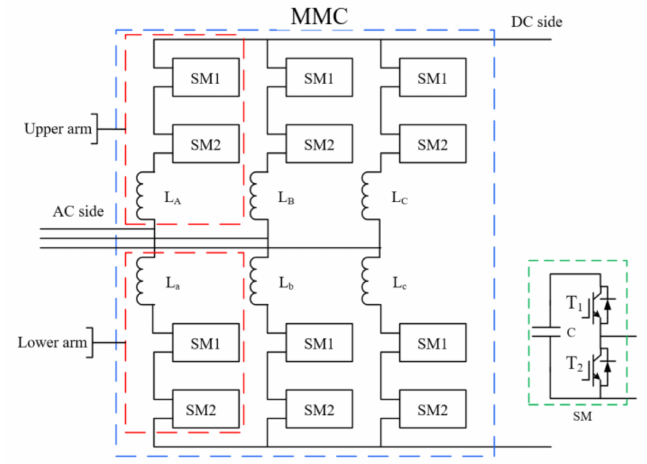
Figure 2. MMC topology.